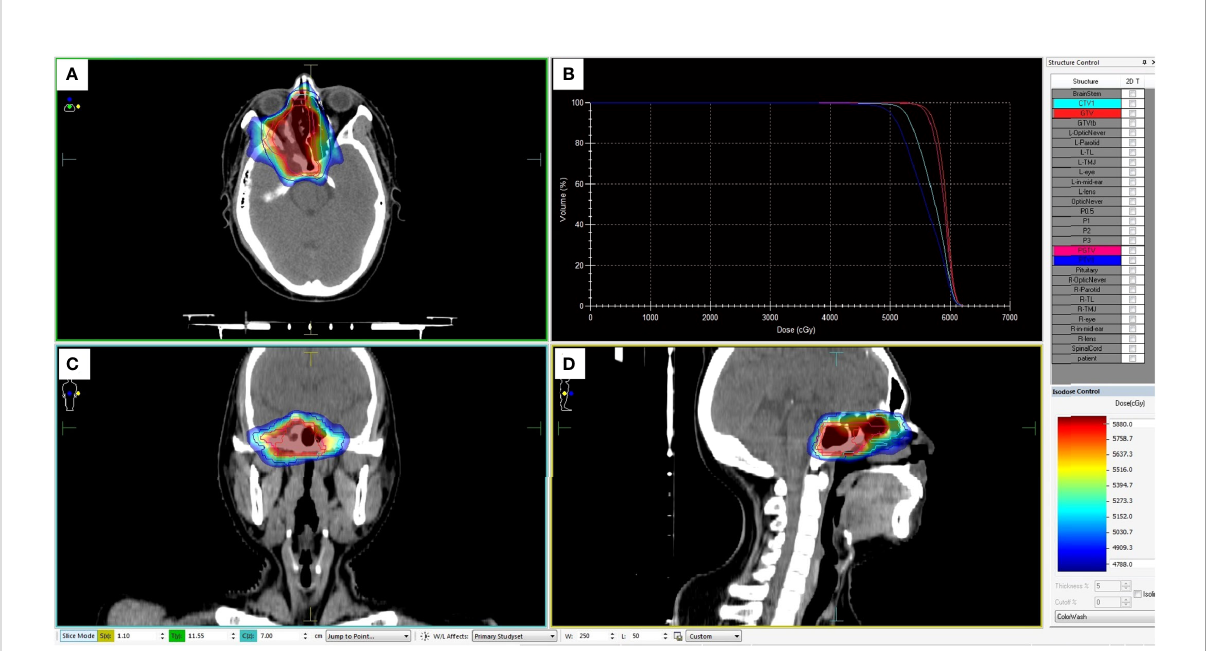
FIGURE 6 Dose planning of radiotherapy. Planned target volume (GTV: red, PGTV: pink, CTV: light blue, and PTV: blue) covered by the 95% isodose can be seen in axial (A) , coronal (C) , and sagittal (D) planes on pretreatment planning computed tomography. (B) The dose-volume histogram showed that 95% of the PGTV and PTV volumes irradiated with more than 5,040 cGy and 5,600 cGy.